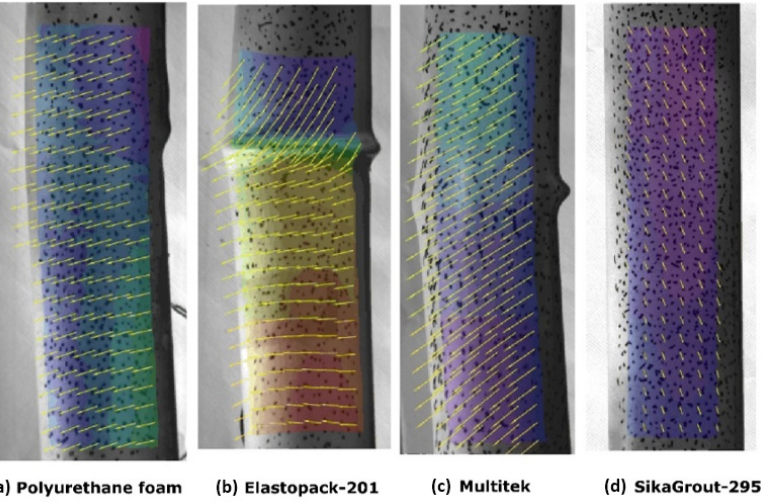
Figure 10. Deformation vector flow at the end of the test; Core filler materials: ( a ) Polyurethane, ( b ) Elastopack-201, ( c ) Multitek, and ( d ) Mortar (SikaGrout-295).